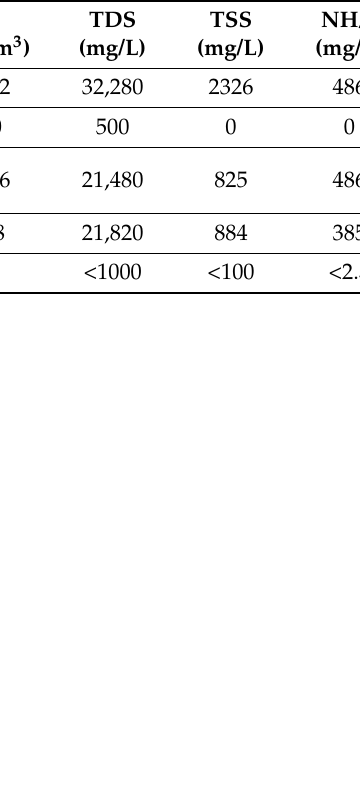
Figure 1. Experimental set-up (Stage 1). Table 3. Variables related to the electrochemical